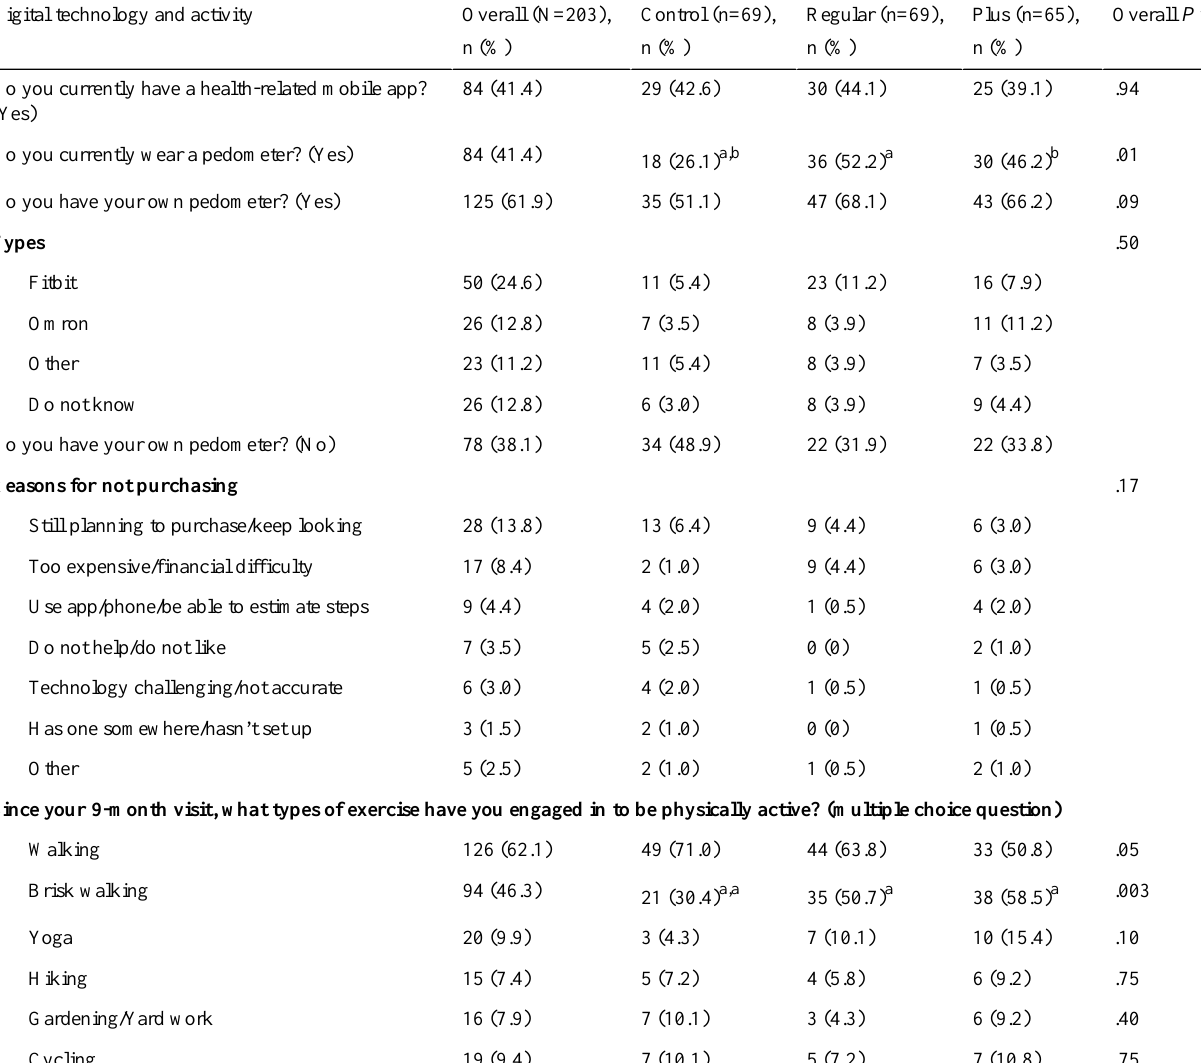
Table 1. Use of digital technology and physical activity at 12 months after the intervention. The presence of two footnotes indicate a pairwise comparison.